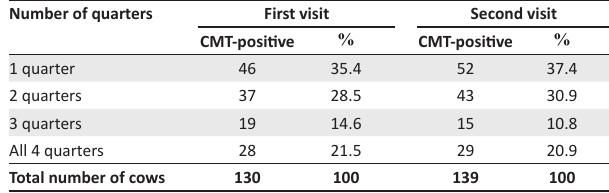
TABLE 2: Distribution of cow infections, by number of quarters infected, based on California Mastitis Test results for the first ( n = 130) and second ( n = 139) farm visits from Mukurwe-ini and Nakuru Districts, Kenya, June 2010 to August 2010.